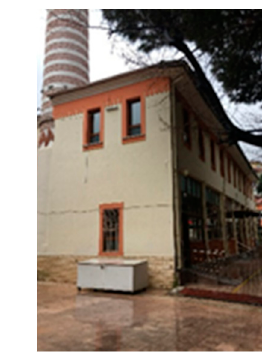
Figure 5. Main and women’s prayer hall of Attar Ece Mosque (photos by the